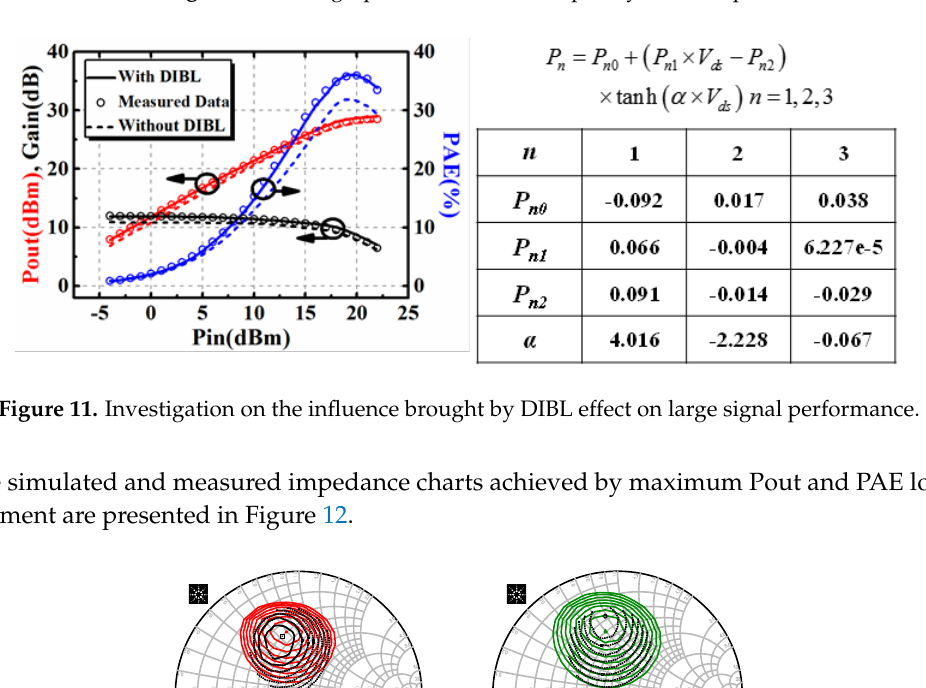
Figure 10. Photograph of on-wafer load–pull system setup.